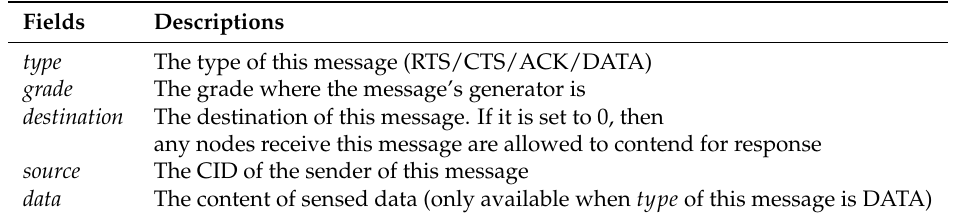
Table 2. The general message